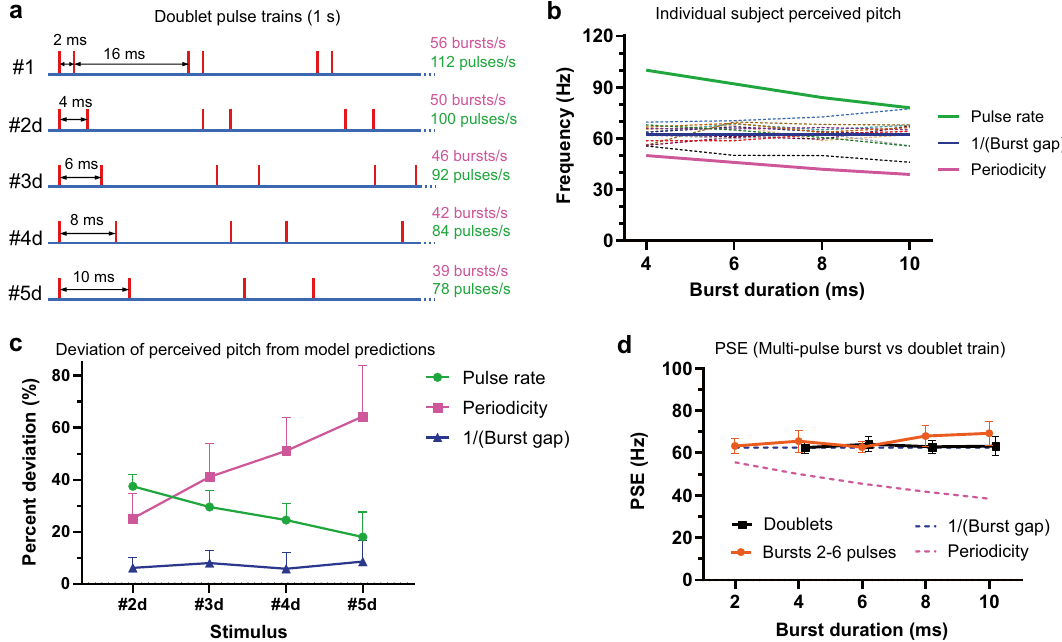
Figure 3. Pulse count within bursts of trains marginally influences the perceived pitch. ( a ) Schematic representation of acoustic pulse trains used in experiment 2, each vertical line indicates the timing of a pulse. The index ‘d’ stands for doublet train. It distinguishes corresponding stimuli from those in experiment 1. Trains are identical in burst duration, and inter-burst interval (fixed across the stimuli). ( b ) PSEs elicited by the stimuli illustrated in panel ( a ). Dashed lines represent experimentally obtained individual subjects’ PSEs. Solid lines indicate predicted PSE values by pulse rate (green), reciprocal of burst gap (blue), and periodicity/burst rate (pink). ( c ) Deviation of subjects’ PSEs (n = 13) for each test stimulus from its rate, periodicity and burst gap predicted values, expressed as a percentage of the predicted value. Each data point represents mean and SD. ( d ) Comparing PSEs evoked by corresponding stimuli in experiments 1 and 2. PSEs for perceived pitch of doublet trains illustrated in panel ( a ) (black line with squares, n = 13). PSEs for stimuli in experiment 1 (illustrated in Fig. 2a) are plotted for comparison (orange line with circles, slightly shifted horizontally, n = 13). Dashed lines represent PSE values predicted by the burst gap model (blue) and periodicity (pink). Error bars denote ± 95% confidence